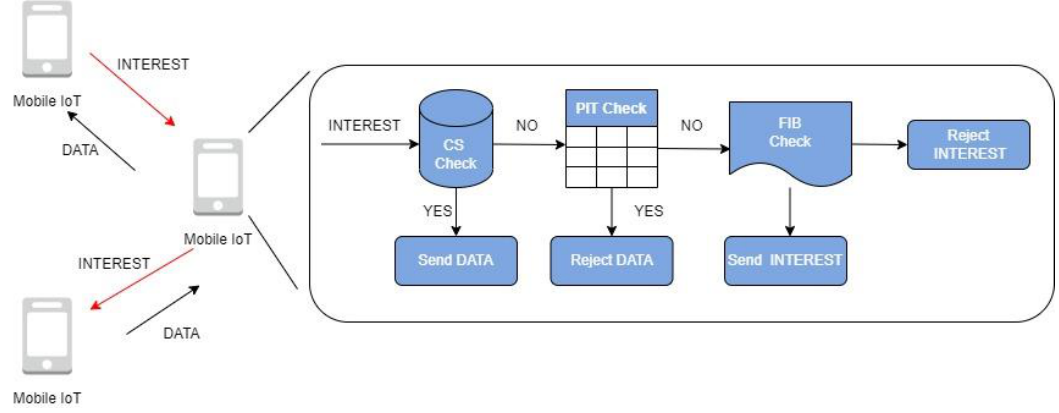
Figure 2. NDN forwarding strategies.